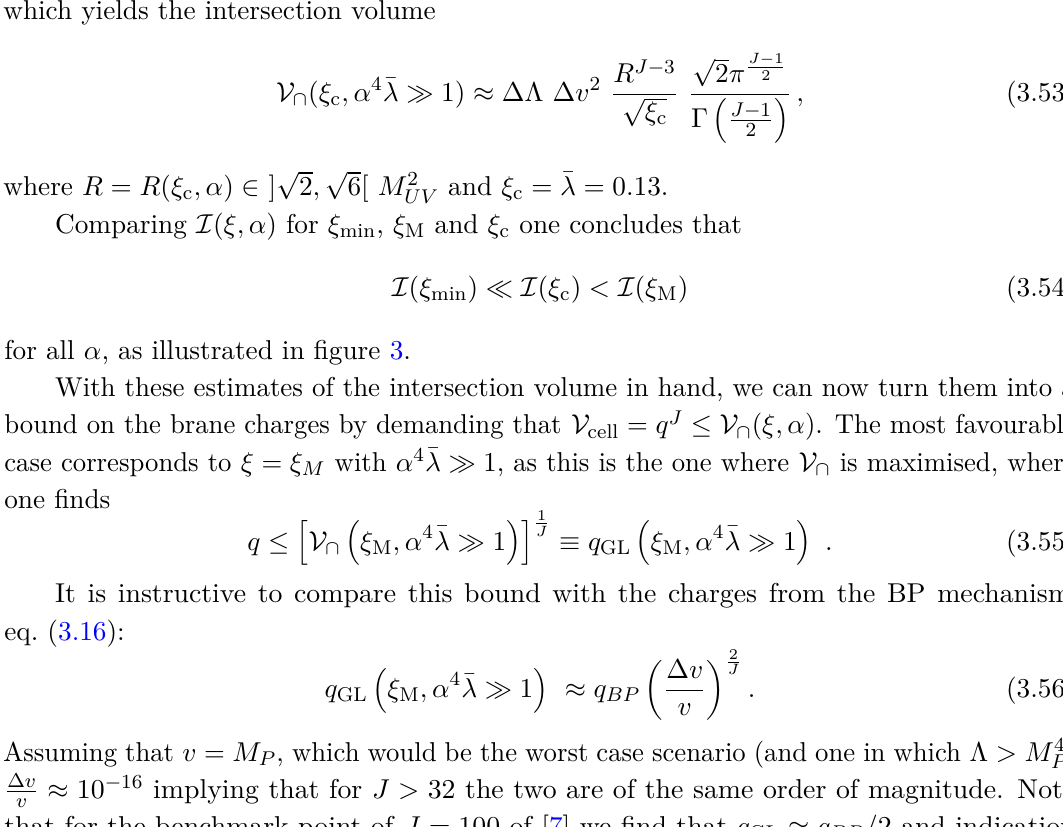
Figure 3 . Left: I ( ξ ) in units of I ( ξ M ) for J = 100 , | Λ | = M 4 ξ min = 4 × 10 − 4 and ξ M = 0 . 036 . Continuous pink line corresponds to the exact result of eq. (3.40) while the dashed grey line represents the approximation of eq. (3.45). Right: I ( ξ c ) the hierarchy parameter α